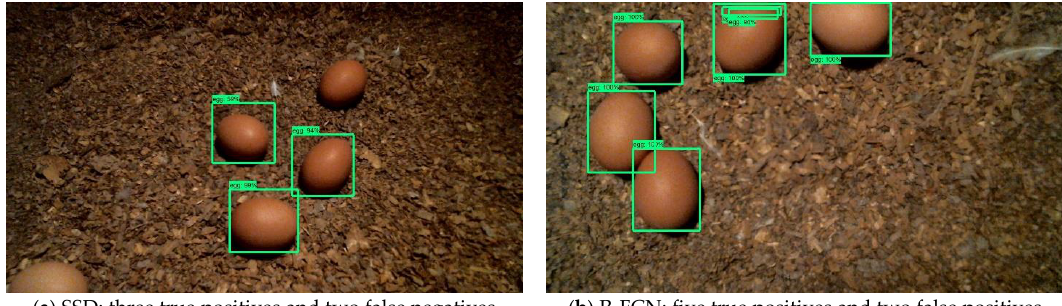
Figure 7. Sample images of erroneous floor egg detection by the SSD ( a ) and R-FCN ( b ) detectors. Eggs in the images are detected and enclosed with green bounding boxes.